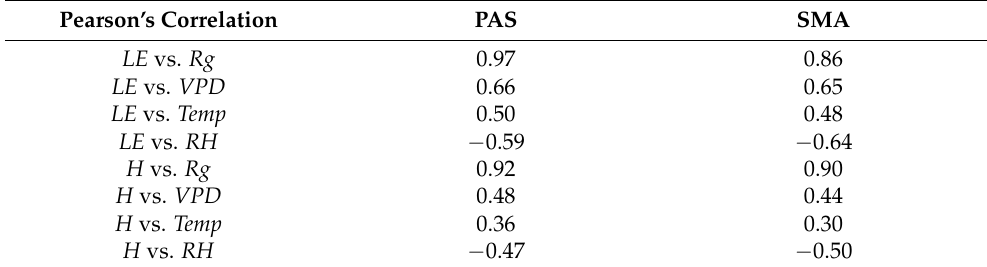
Table 3. Pearson’s correlation (r) coefficients between the LE and H with environmental variables for the SMA and PAS sites, from 1 September 2014 to 1 September 2016, in a half-hour base with a p -value of 0.001. Pearson’s Correlation PAS SMA LE vs.